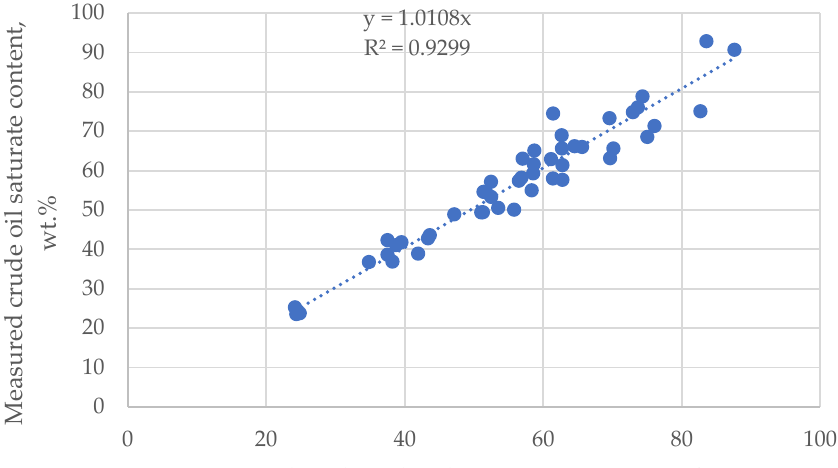
Predicted crude oil saturate content, wt.%